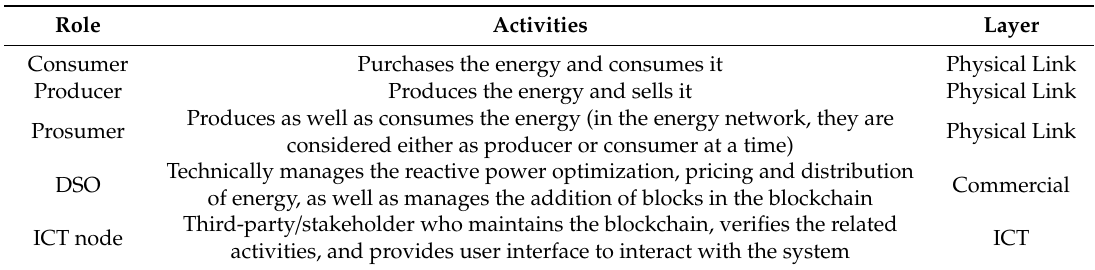
Table 1. Roles and activities in the proposed